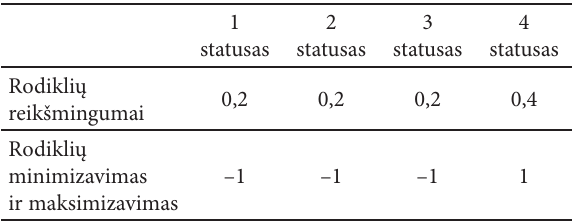
Table 2. The importance of land parcels index and their minimum